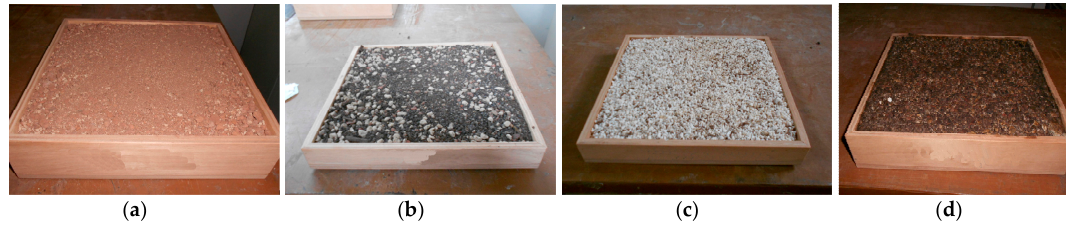
Figure 1. Extensive samples inserted in the relevant containment systems, ready for the thermal flow meter method tests; ( a ) Factory 1, ( b ) Factory 2, ( c ) Factory 3, ( d ) Factory 4.